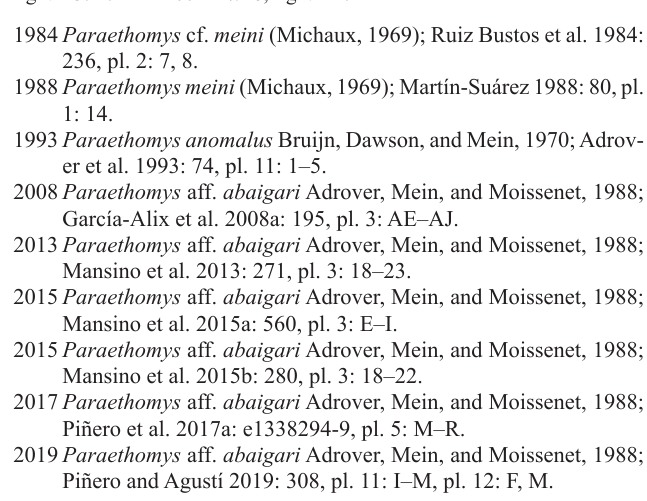
Fig. 3. Upper and lower dentition of the murid rodent Paraethomys baeticus sp. nov. from Baza-1, early Pliocene, Guadix-Baza Basin, Spain, in occlusal view. A . BA1-2001-R7/2, left M1 (holotype). B . BA1-2001-R7/5, right M1. C . BA1-2001-R7/16, right M1. D . BA1-2001-R7/22, right M2. E . BA1-2001- R7/24, right M2. F . BA1-2001-R7/25, right M2. G . BA1-2001-R8/20, right M3. H . BA1-2001-R8/17, left M3. I . BA1-2001-R7/32, right m1. J . BA1-2001-R8/12, left m3. K . BA1-2001-R7/62, right m2. L . BA1-2001-R7/43, left m1. M . BA1-2001-R7/73, right m2. N . BA1-2001-R7/78, right m2. O . BA1-2001-R8/3, right m3. P . BA1-2001-R7/48, right